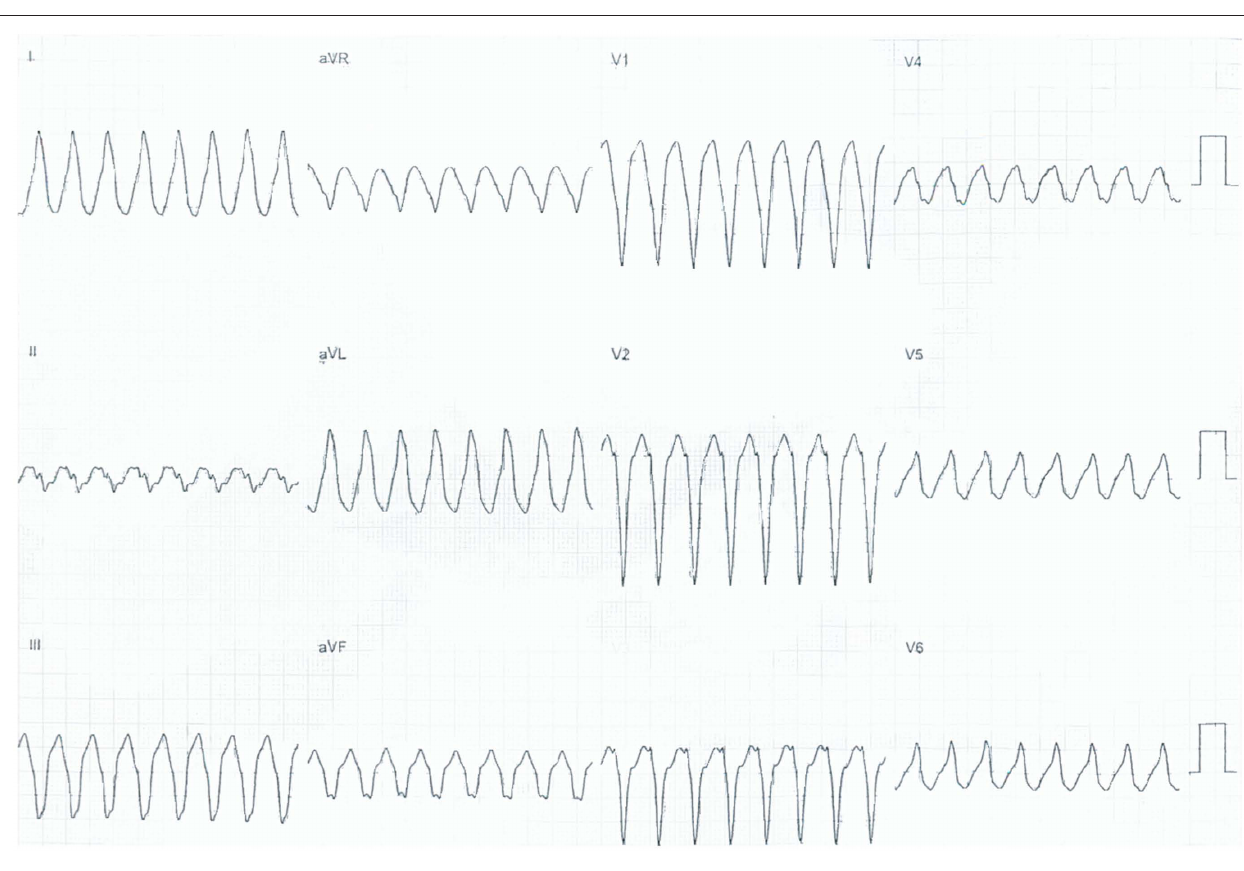
Figure 1 | LBBB/superior axis VT from a patient with